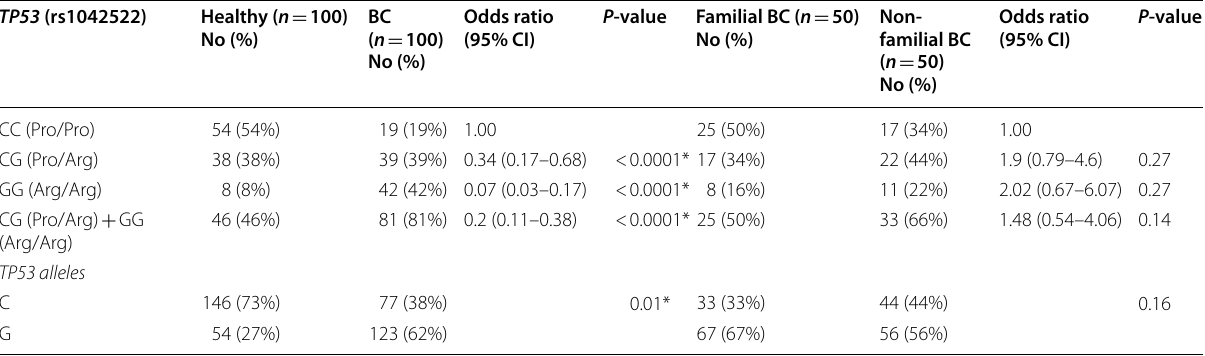
Table 3 Genotype and allele prevalence of TP53 (rs1042522) polymorphism among studied groups using SNPstat software TP53 (rs1042522)